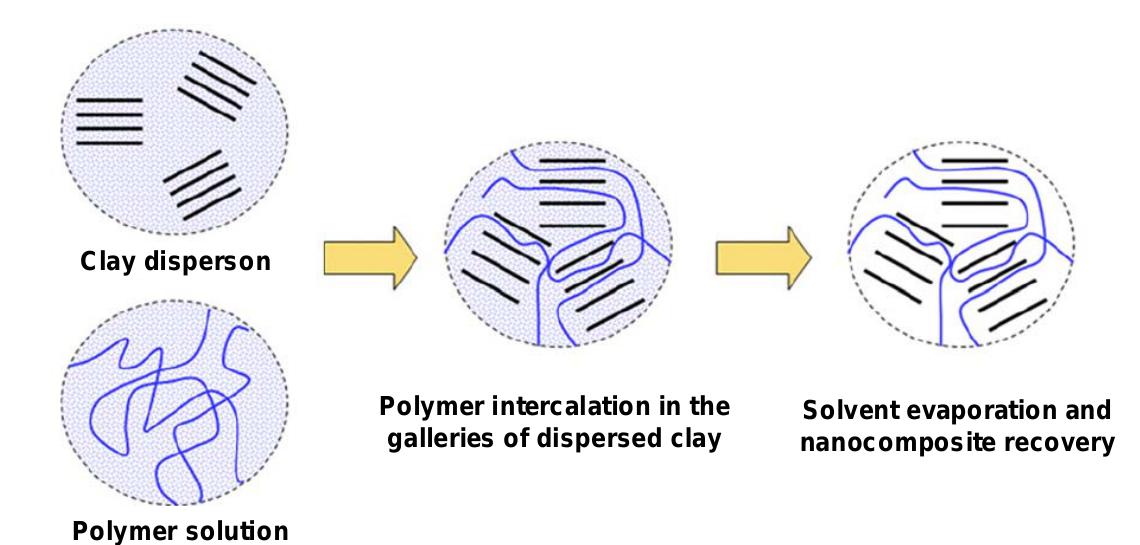
Figure 15. Schematic representation of polymer adsorption from solution. Reproduced from reference [4] with permission from